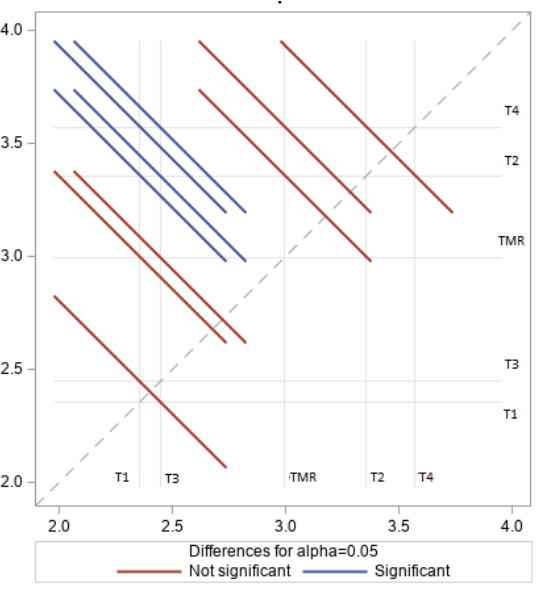
Figure 2. Effect of treatments on linoleic acid (LA %) content of longissimus dorsi (LD) fat muscle in Naemi lambs.